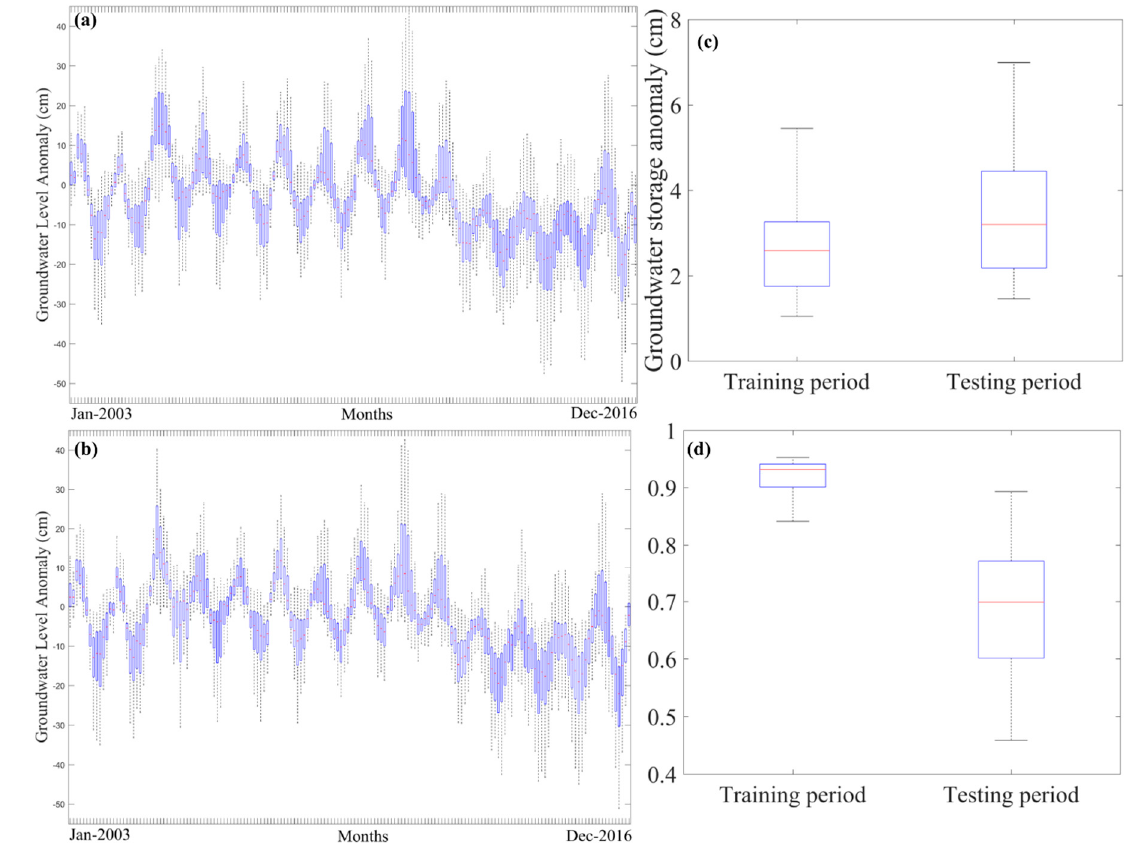
Figure 8. Boxplots summarizing ( a ) ARIMA simulated groundwater anomaly during the historical period (January, 2003–December, 2016) ( b ) GRACE-derived groundwater anomaly during historical period ( c ) distribution of RMSE and ( d ) NSE during training (January, 2003–December, 2014) and testing period (January, 2015–December, 2016) for all grids within the Colorado River basin. Figure 9a,b summarizes the forecasted monthly GRACE-derived ∆ GWS in centimeters (cm) for upper CRB and lower CRB respectively. Each box plot shows the distribution of a monthly forecasted ∆ GWS of entire grids independently for both upper and lower CRB. The boxes represent the corresponding 25th, and 75th percentile ∆ GWS and the red lines represent median ∆ GWS. Similarly, the whiskers represent the 5th and 95th percentiles of the corresponding ∆ GWS. If the boxes lie in the positive ordinate, it shows the month will have higher groundwater storage as compared to the corresponding historical months. From Figure 9a,b, future groundwater in lower CRB is expected to decline more as compared to upper CRB as the distribution of ∆ GWS is more negative for lower CRB represented by the boxes with minimal ordinates for lower CRB. It is the reflection of the ARIMA’s property of making forecasts based on the historical variations as, during the recent historical drought period, groundwater within arid and drought-affected regions CRB was withdrawn to supplement the scanty surface water. Further, the ARIMA model was able to capture the seasonality in the groundwater anomalies. From Figure 9a, it was observed ∆ GWS showed positive anomaly for most of the grids in upper CRB in the months like March, April, and May as the median ∆ GWS was generally positive. This can be attributed to the groundwater recharge from early snowmelts as a result of changing the climate, in the snow-covered regions of upper CRB. Most of the grids especially in lower CRB showed negative anomalies for all months. This shows the groundwater condition of the CRB is unlikely to improve in the near future as compared to the historical records. This can